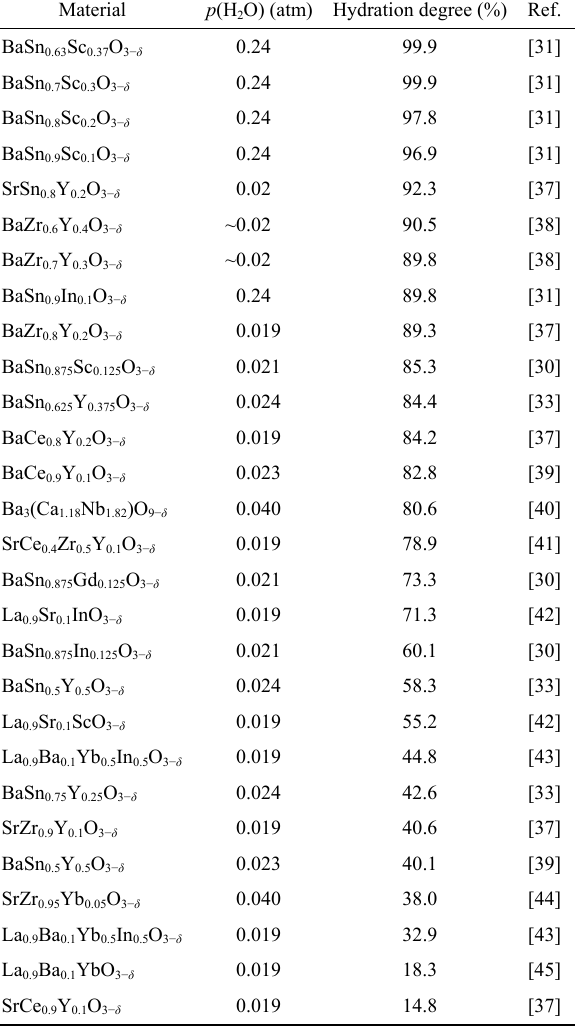
Table 1 Hydration degrees of the best-studied proton- conducting materials